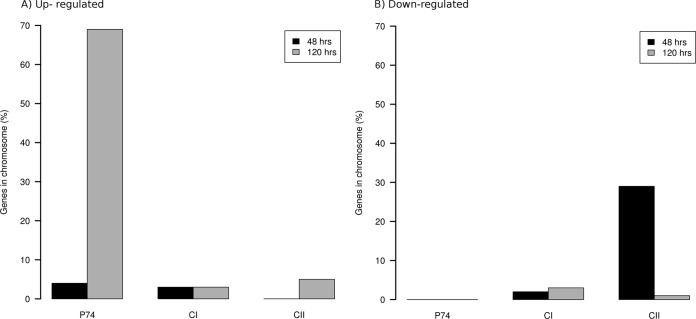
Number of genes (percentage) in each replicon with differential expression. The bar graphs show the percentage of each L. biflexa replicon (measured as number of differentially expressed genes over total number of genes in the replicon) that were upregulated (A) and downregulated (B).